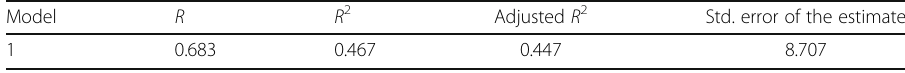
Table 4 Model summary for the language proficiency subskills as predictors of emotional exhaustion Model